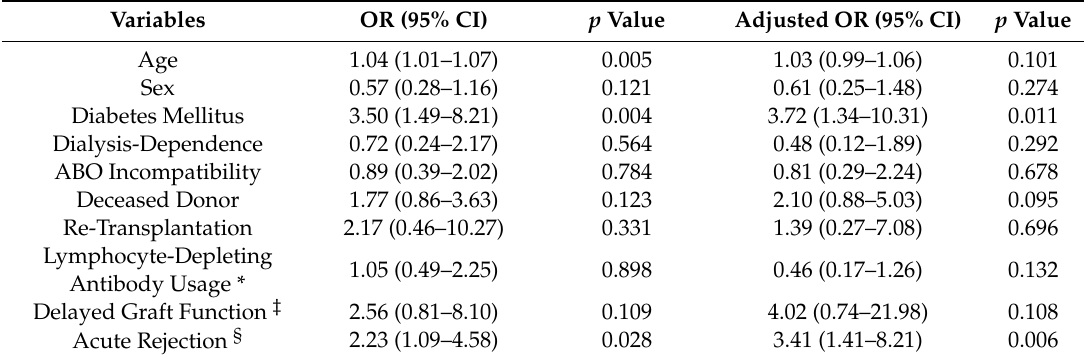
Table 2. Risk factors for the development of invasive fungal disease (IFD) in patients after kidney transplantation (KT).